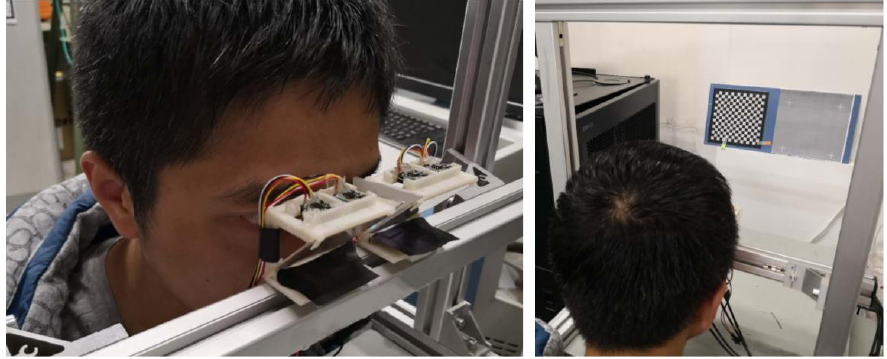
Figure 4. Customized gaze tracking system, with four cameras in 640 × 580 resolution, which can be converted into a head-mounted device.